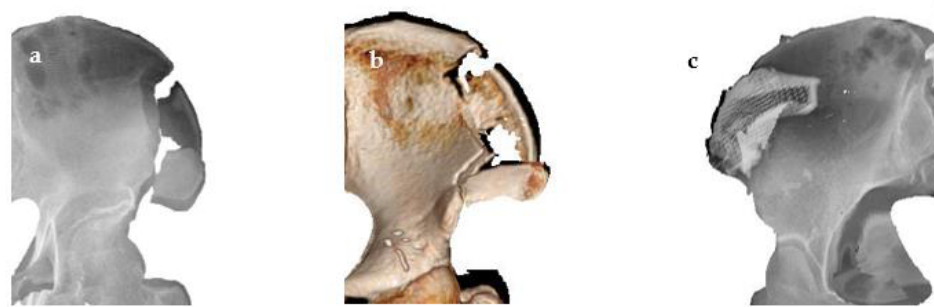
Figure 1. Three-dimensional modeling of fractured patients; ( a ) the fractured iliac bone images of patient 1. The patient had to undergo open reduction and internal fixation; ( b ) fractured pelvis of patient 2. Conservative treatment led to the recovery of the fracture site; ( c ) 3D reconstruction model of patient 3, showing the reduced fracture segment after reduction with a 3D titanium implant.